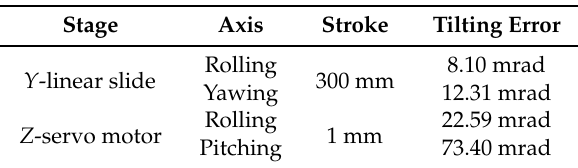
Table 2. Summary of tilting errors of the positioning